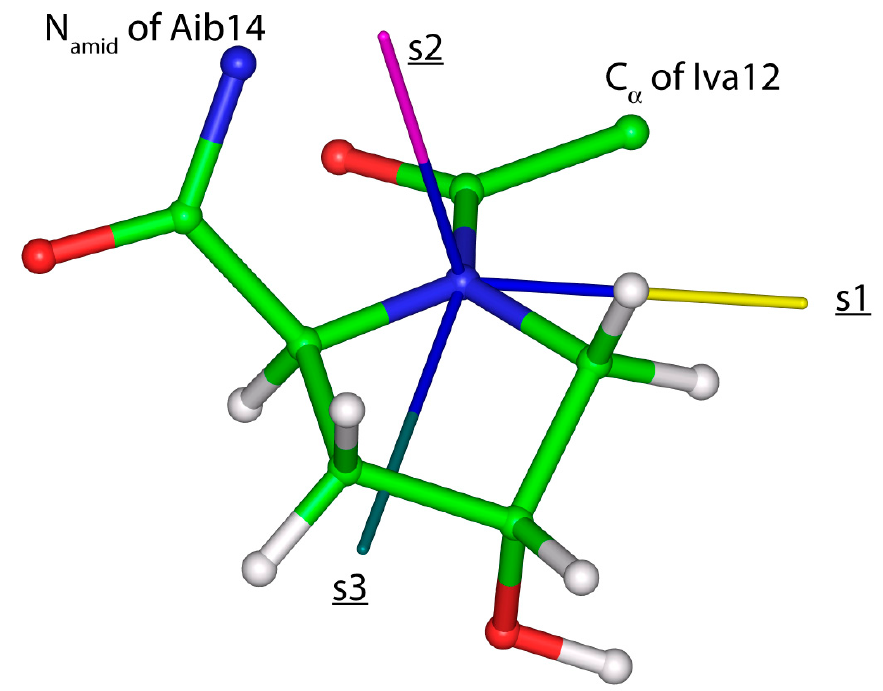
Figure 6. The fragment of samarosporin I with visualized eigenvectors associated with the eigenvalues of the 15 N amid chemical shielding tensor of Hyp13 residue (an eigenvector pertaining to the smallest, mid- and highest eigenvalue is colored in yellow, pink and dark green, respectively, and accordingly denoted as s1, s2 and s3).